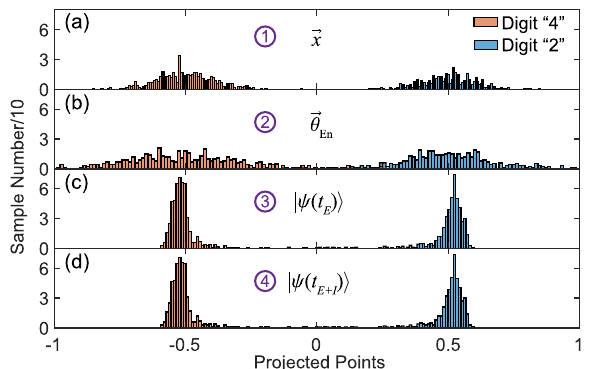
Fig. 4 The projected points by using LDA, where the distance between the projected cluster centers is normalized. The positions of ① ~ ④ along the data fl ow are shown in Fig. 1. a The projected points of the original 784-dimensional handwritten digits. b The projected points of the control pulses for encoding the classical data to the quantum states. c The projected points of the quantum states after the encoding block. d The projected points of the fi nal quantum